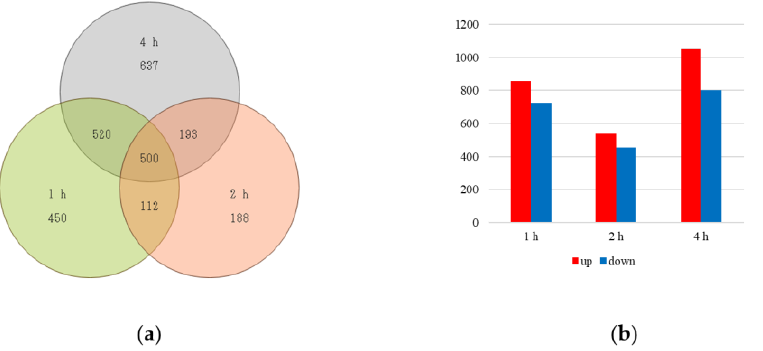
Figure 1. ( a ) Venn diagrams of DEGs in the three groups marked as 1 h treatment versus before treatment, 2 h treatment versus before treatment, and 4 h treatment versus before treatment, respectively. ( b ) Up- or downregulated DEGs in pairwise comparisons marked as 1 h treatment versus before treatment, 2 h treatment versus before treatment, and 4 h treatment versus before treatment, respectively.